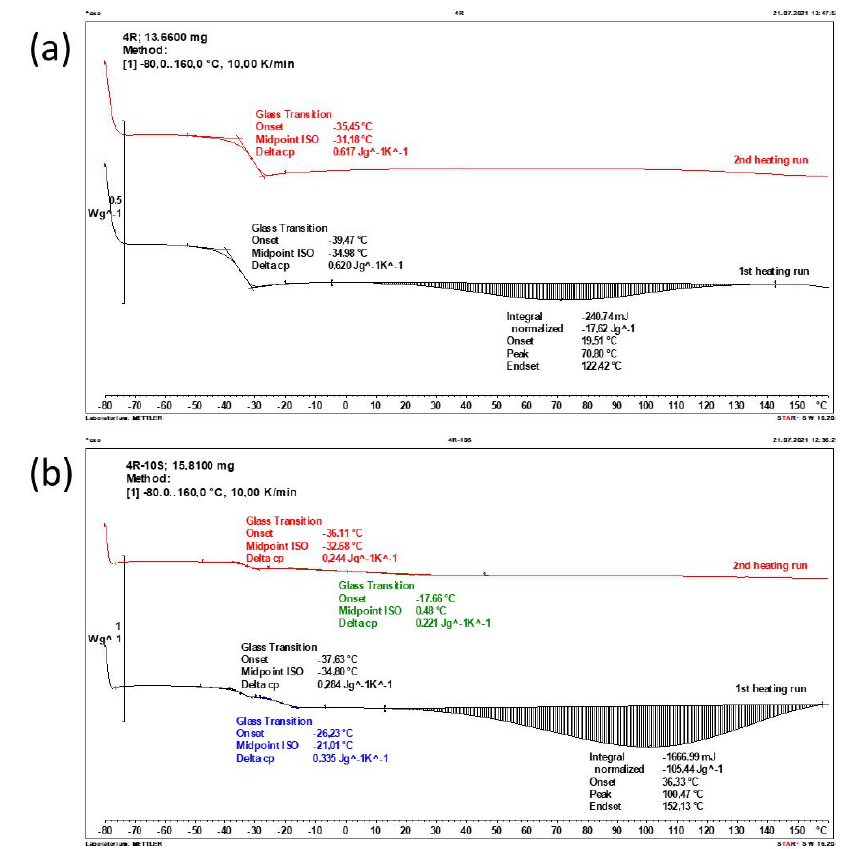
Figure 7. DSC trace of ( a ) 4R (polyMEA with 4 wt.% of RDS clay); ( b ) 4R-10S (polyMEA with 4 wt.% of clay and 10 mol% of SMA co-monomer in the matrix). Table 2. Temperatures of glass transition (T g , determined as T of mid-step in heat capacity), as well as the associated changes in heat capacities for the most important among the studied nanocomposite elastomers, as well as for some reference materials: T g (1) is the transition at lower temperature, T g (2) is the higher-temperature transition; the values in brackets refer to the first heating run, without brackets to the second heating